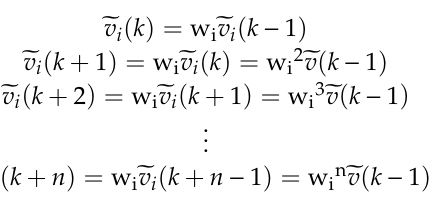
Figure 6. Built ‐ in robotic arm. Since the construction of each mechanical part is designed to fit together, the result of mass center analysis and appropriate weight distribution allows the platform and arm to be unified into a single robotic system, as shown in Figure 7.